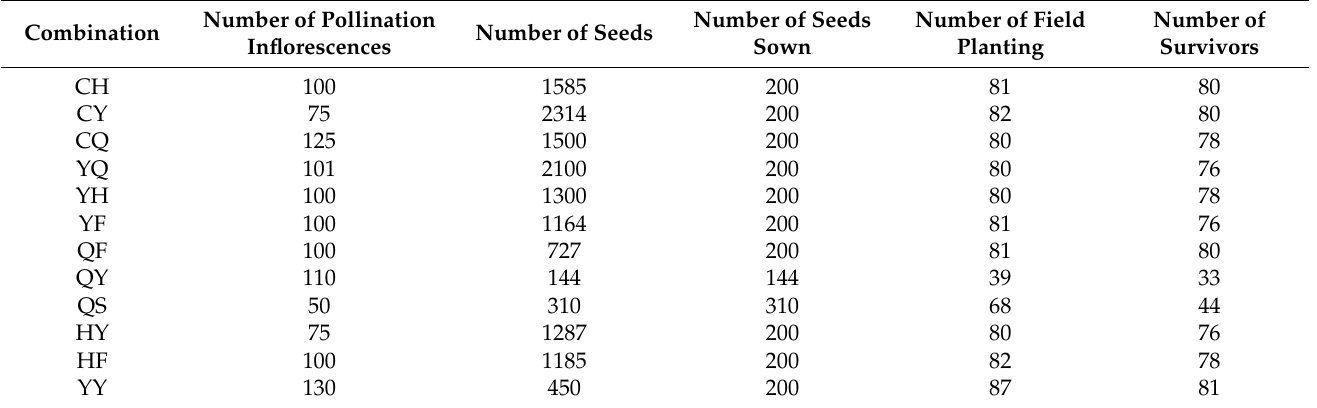
Table 2. Statistics of hybridization and F1 generation